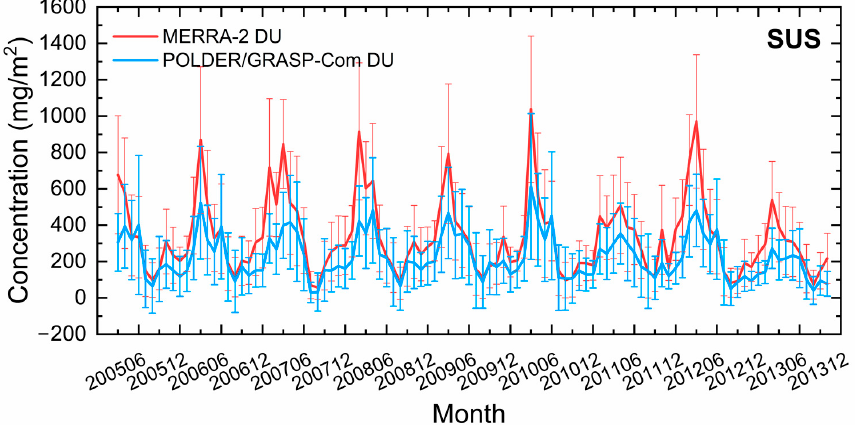
Figure 9. Same as Figure 3, but for Sub-Sahel (SUS) region.